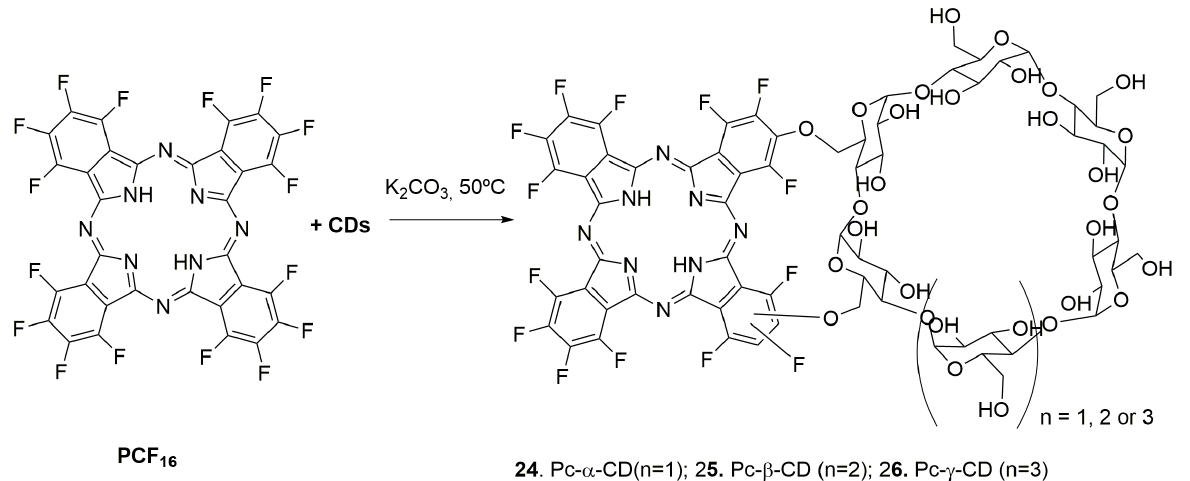
Figure 23 - Synthesis of amphiphilic phthalocyanines (PCs) conjugated with α-, β- and γ-